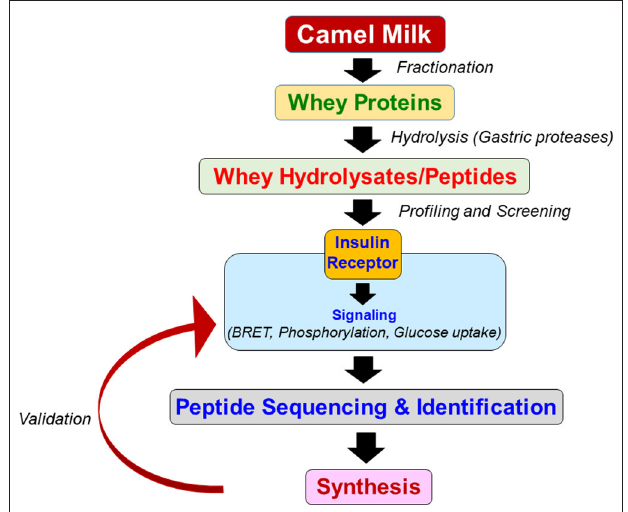
FIGURE 3 | Flowchart of the experimental approach used for CM fractionation and profiling. The raw whey proteins are firstly separated and extracted from freshly collected CM. Thereafter, the proteins were subjected to hydrolysis using the major gastric endopeptidases resulting in various hydrolysates obtained from different experimental protocols. The CM whey hydrolysates and derived peptides are then screened and profiled for their bioactivity and functional action on IR using cell lines and employing different assays including BRET, phosphorylation assay, and glucose uptake. The most active and potent hydrolysates and peptides are sequenced for peptide content and identification. Finally, the most relevant peptides are synthesized and validated again on IR activity using cellular